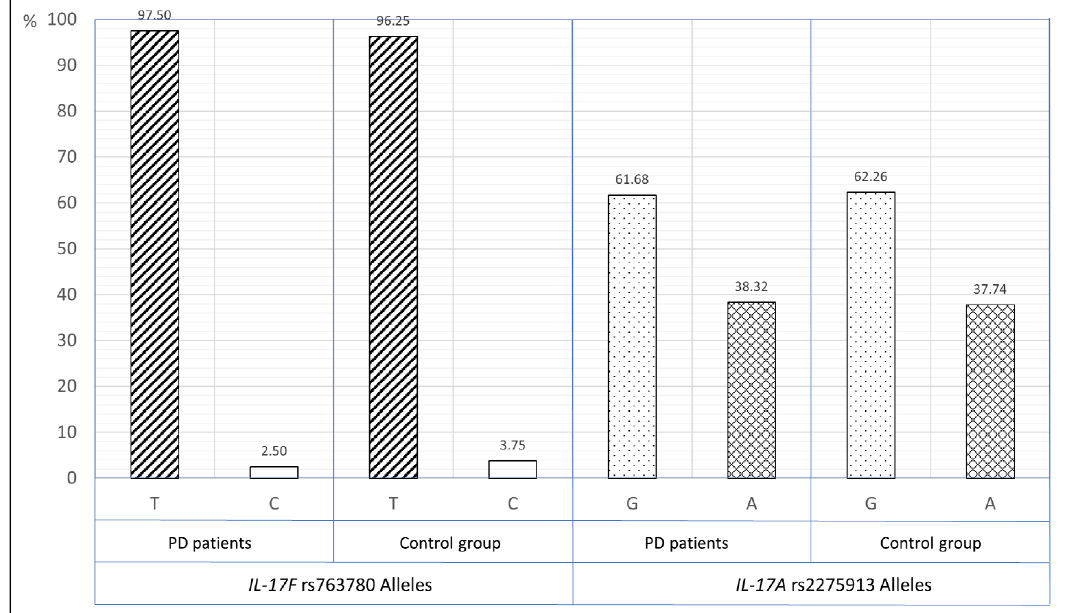
Figure 1. The distribution of IL-17F rs763780 and IL-17A rs2275913 alleles in periodontitis patients and control group.